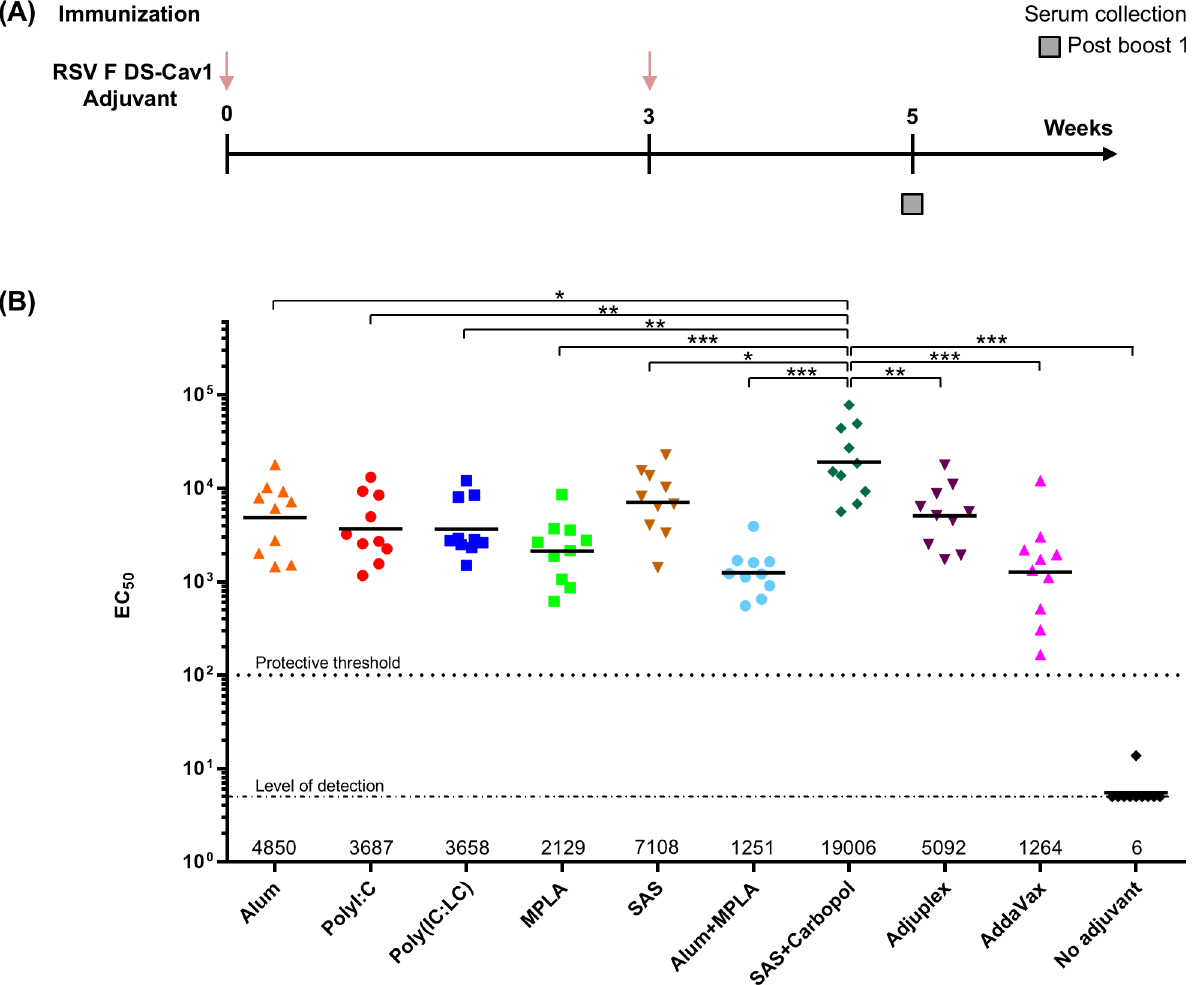
Fig 1. Adjuvants augment DS-Cav1response in mice. (A) RSV F (pre-F) DS-Cav1 formulated with nine different adjuvants was used to immunizemice at an interval of 3 weeks and (B) neutralization titers for all nine adjuvanted plus the control unadjuvanted groupsare shown. Scatter plots show the geometricmean (numerical value below),each group included10 mice. The palivizumabprotective thresholdis indicatedby a dotted line [10] and p values for SAS + Carbopol/DS-Cav1 versus the other eight adjuvant formulations as assessed by two-tailed Mann-Whitney test and adjustedfor multiple comparisons using the Holm-Bonferroni method; p = > 0.05 (ns); p < 0.05 ( * ); p < 0.01 ( ** ); p < 0.001 ( *** ) are shown. All adjuvanted groups show p < 0.0001 when comparedto the no adjuvant group. Associatedraw data is reportedin S1